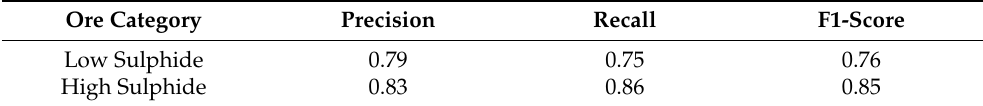
Table 3. Resulting classification metrics of the model.